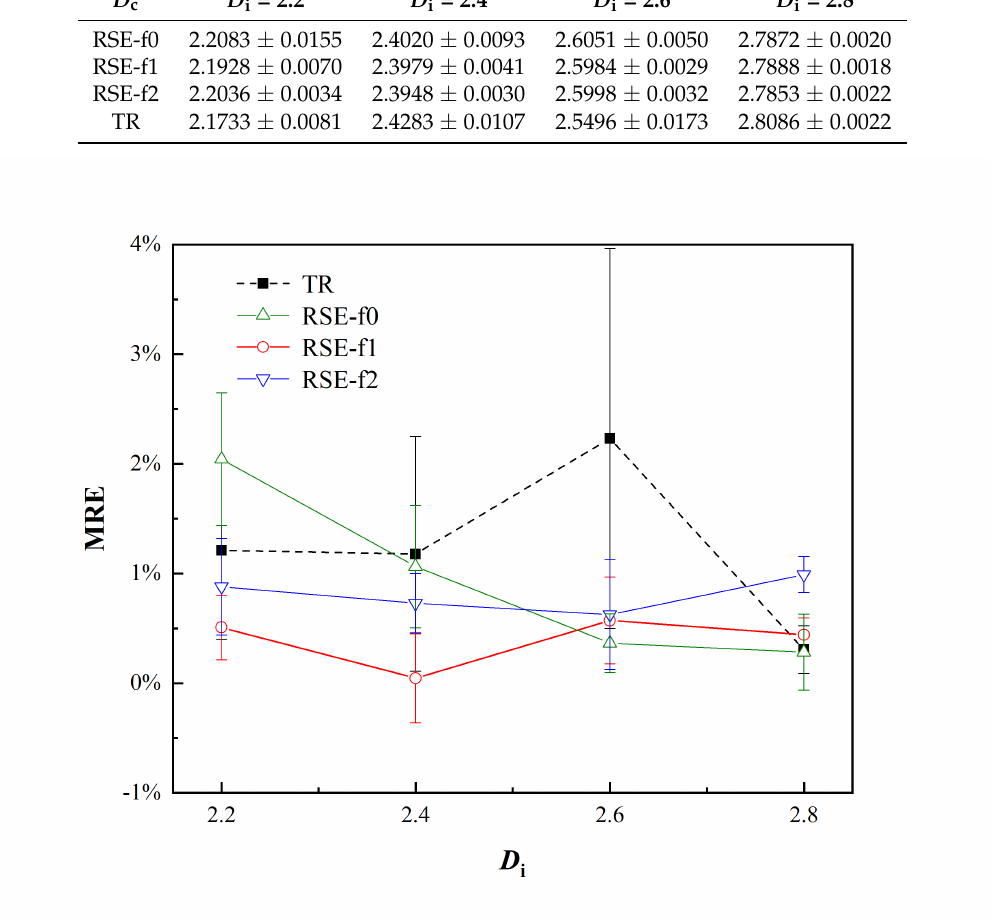
Figure 11. The MRE values for the comparison of D i and D c obtained with different methods, which were listed in Table